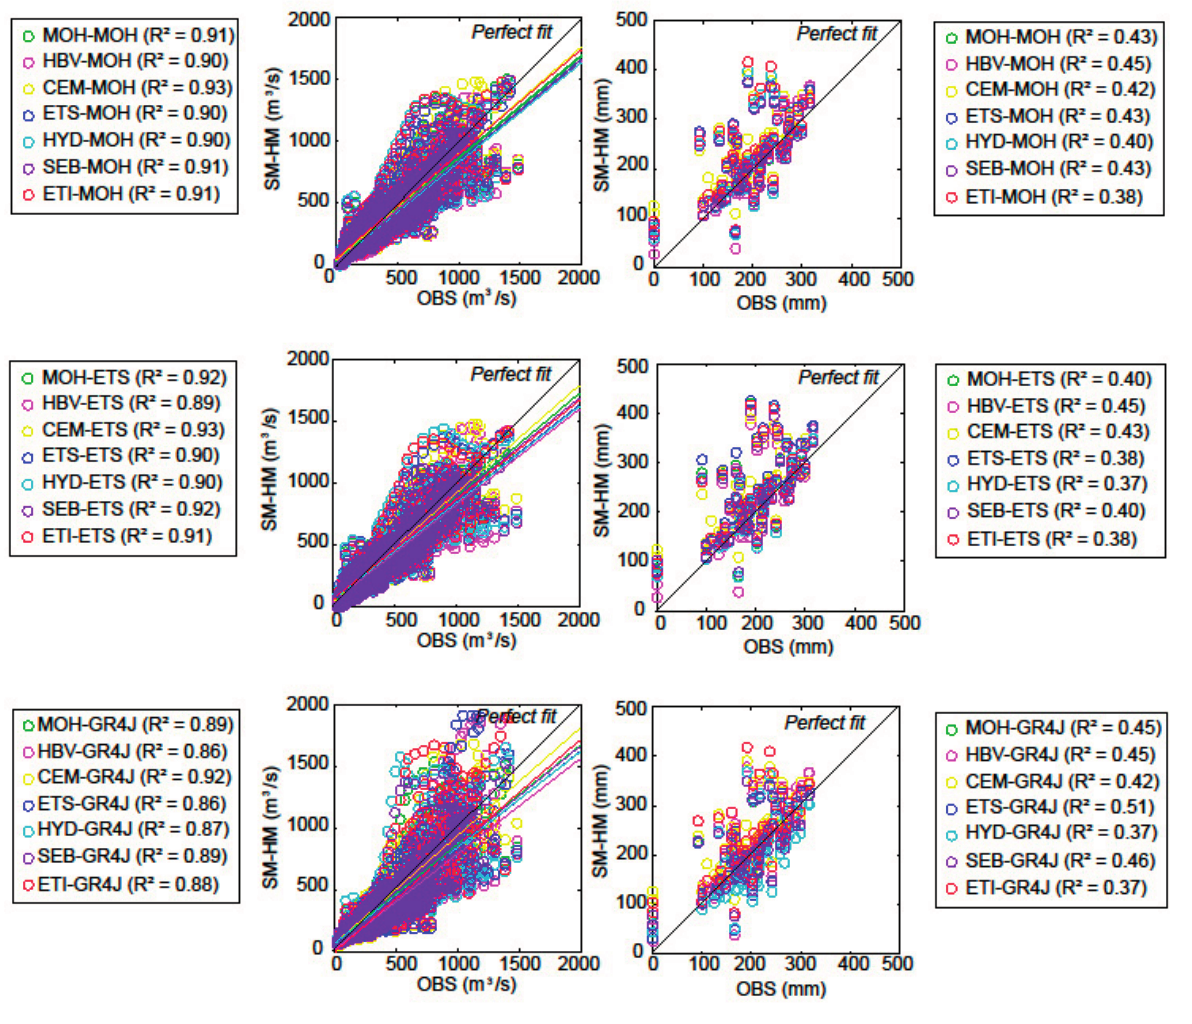
Figure 10. Scatterplots of observed, simulated daily discharges and SWEs with the 21 SM-HM combinations during the validation period (odd years over 1961–2000). The coefficient of determination ( R 2 ) obtained for each SM-HM is also